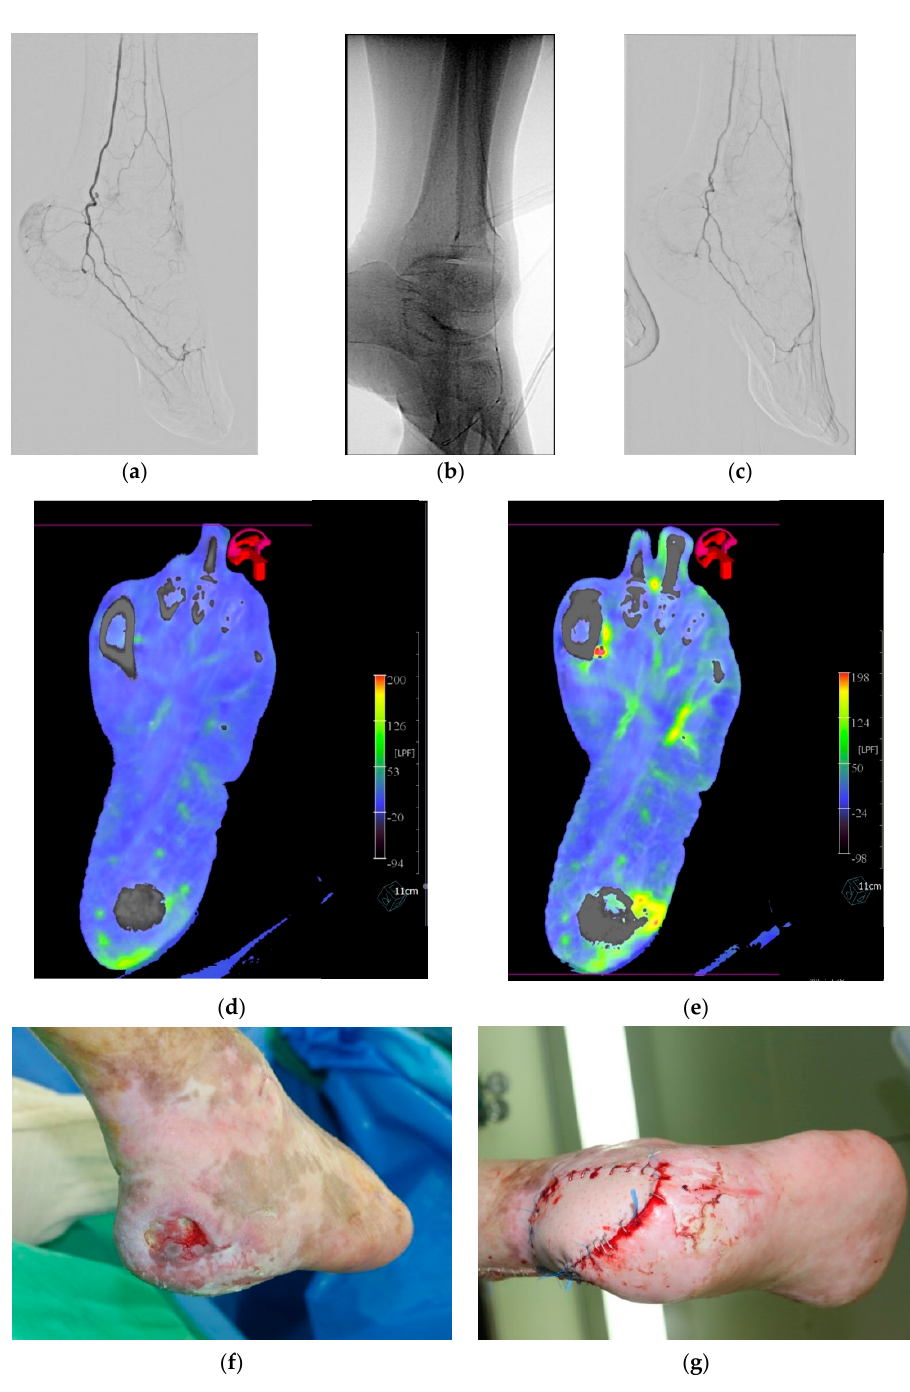
Figure 1. A 73-year-old woman with peripheral arterial disease underwent percutaneous transluminal angioplasty for the first and second toe wound. ( a , b ) Initial angiography shows long segmental occlusion of left anterior tibial artery (ATA) and posterior tibial artery (PTA) and total occlusion of left peroneal artery with decreased flow to the foot including first and second toe. ( c , d ) Recanalization with 0.014-inch guidewire and balloon angioplasty was done with a 2 mm–15 cm balloon catheter. ( e , f ) Completion angiography shows patent left ATA and PTA and increased flow to the foot especially first and second toe. ( g , h ) Cone-beam computed tomography-based foot perfusion mapping before ( g ) and after ( h ) angi- oplasty clearly shows markedly increased perfusion of the foot, especially first and second toe.